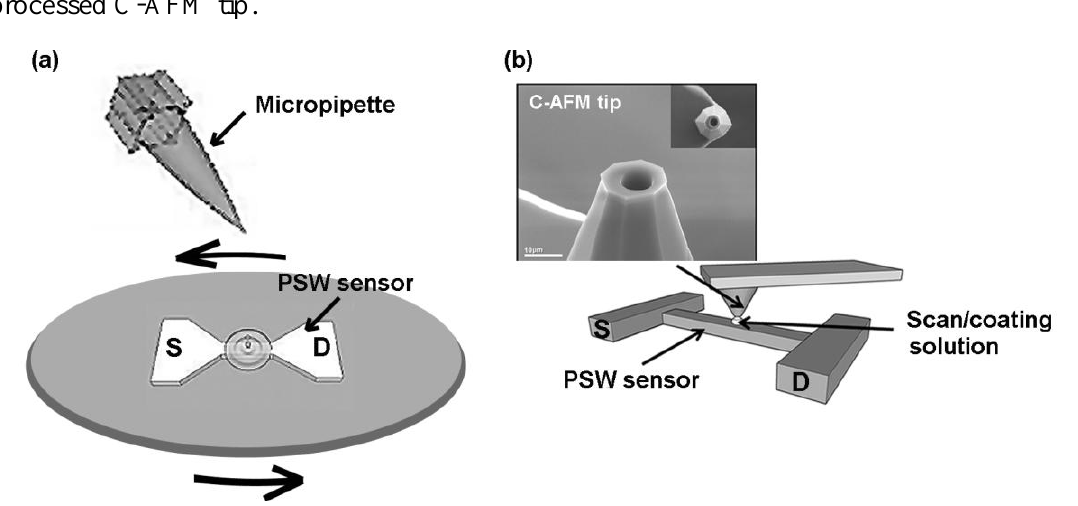
Figure 2. Schematic diagrams of the solution coating processes for (a) micropipette/spin- coating, and (b) FIB-processed C-AFM tip scan/coating. The SEM picture is of the FIB processed C-AFM